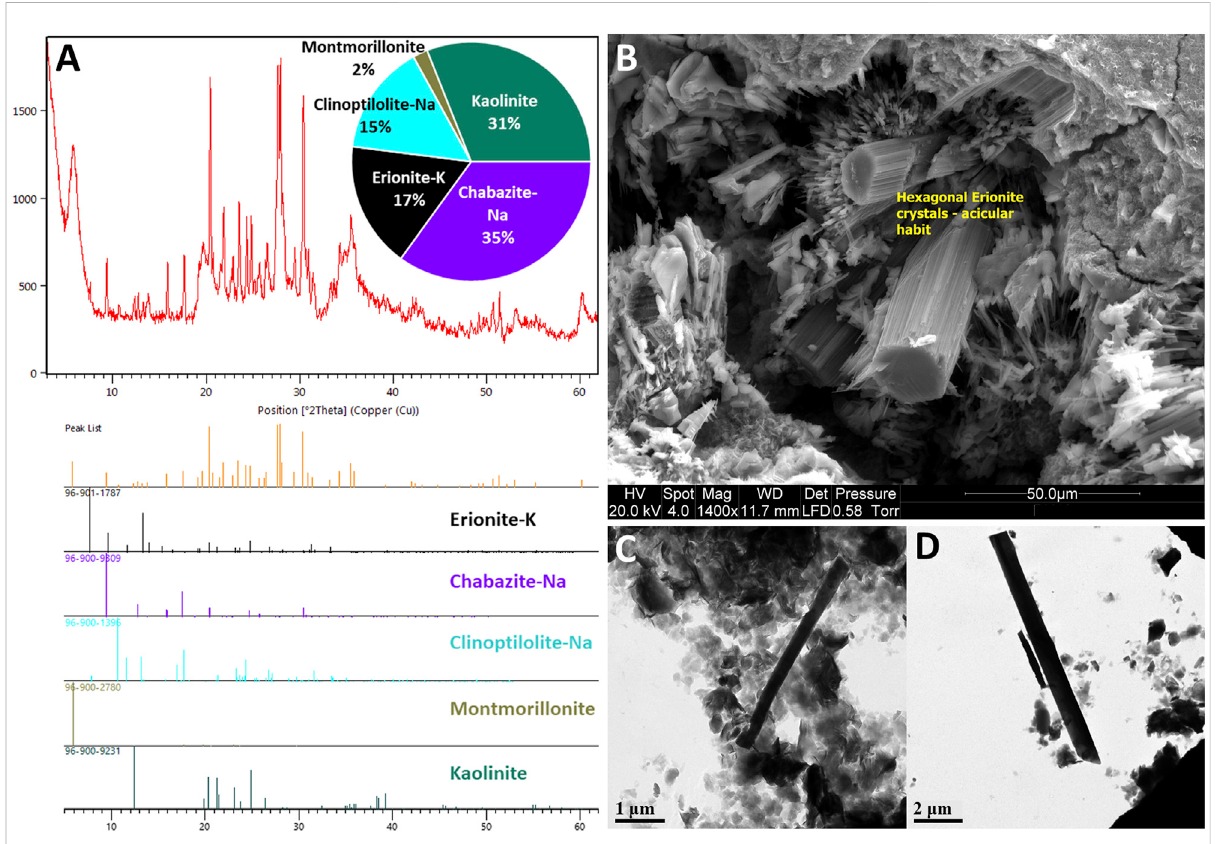
FIGURE 2 Example erionite-K from the Waitemata Group volcaniclastic sediments, Auckland, New Zealand (modi fi ed from Patel and Brook, 2021): (A) X-ray diffraction (XRD) plots showing erionite and other zeolites, including chabazite and clinoptilolite; (B) Scanning Electron Microscopy (SEM) image of example erionite fi bers (yellow boxes), the fi bers have formed hexagonal bundles with an acicular habit and formed within the pore spaces of siltstone undergoing weathering; (C,D) cryogenic Transmission Electron Microscopy (TEM) of example fi bers to determine